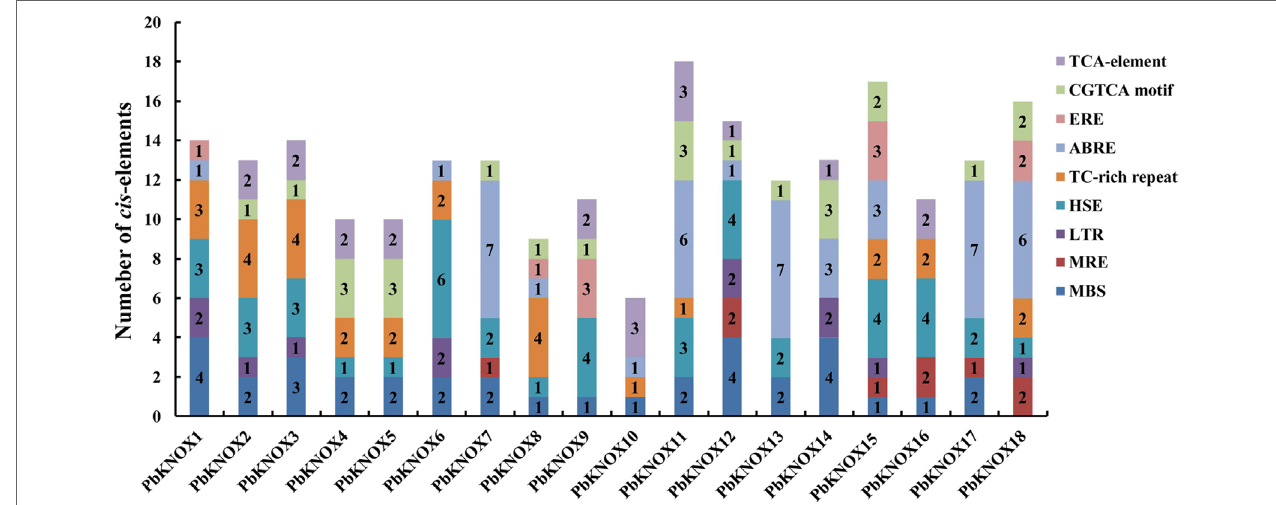
FIGURE 4 | Putative cis -acting regulatory elements in the PbKNOX promoters.